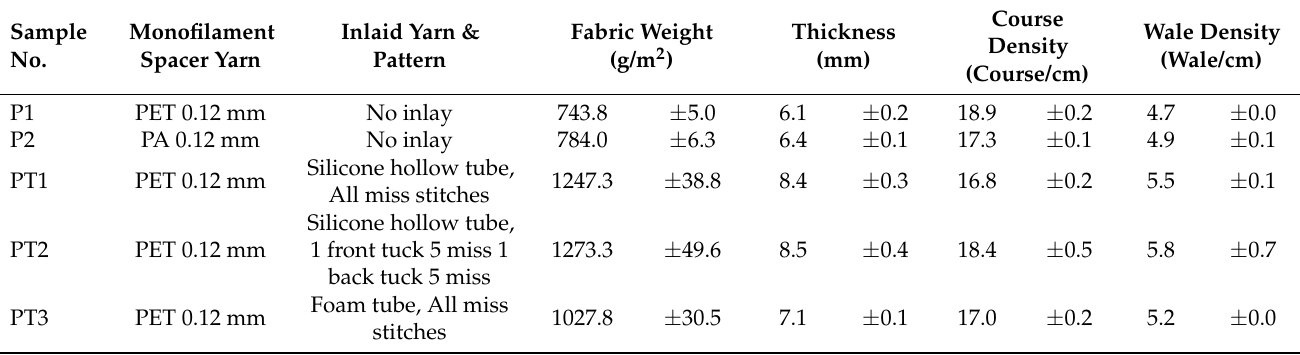
Table 2. Details of the fabric